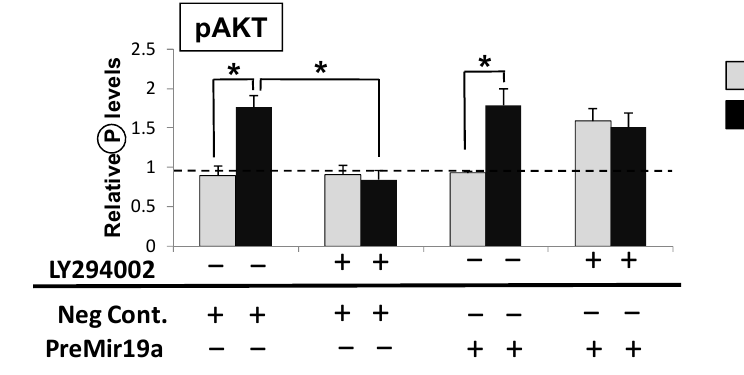
Figure 4. Overexpression of miRs in AKT and MAKP phosphorylation. ( A ) Transfection of miR-19a precursor enhanced AKT phosphorylation; ( B ) Transfection of miR-23b, 27b precursors overrode the suppressive effects of ERK inhibitors on shear-induced ERK, but not p38 and JNK, activation. Pre-MiR-27b overrode the SP600126 inhibition of JNK phosphorylation under shear. Data are presented as the mean ± SEM (n = 3). * p < 0.05.